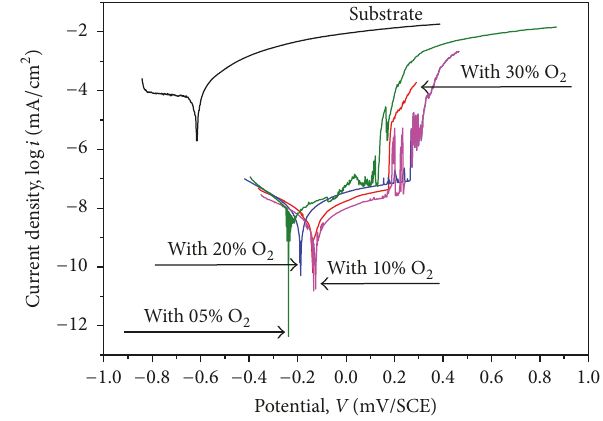
Figure 5: Effect of oxygen flow on the polarization curves of the stainless steel coated and uncoated in 3.5% NaCl solution, obtained at 25 ∘